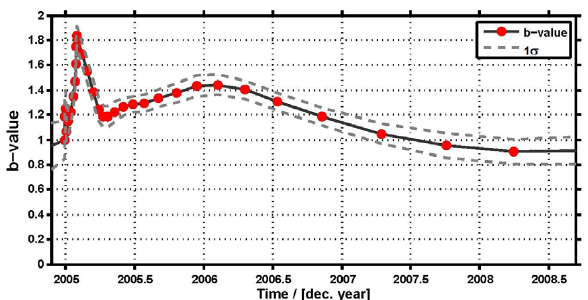
Fig 6. Temporal variation of b -value (thick line) in the Andaman arc region through a period from 2004 until 2009. Dashed line on either side of the thick line corresponds to Fig. 6. Temporal variation of b -value (thick line) in the Andaman one standard deviation ( σ = 1 s.d.) in the b -value estimates. arc region through a period from 2004 until 2009. The dashed line on either side of the thick line corresponds to one standard deviation ( σ = 1s.d.) in the b -value